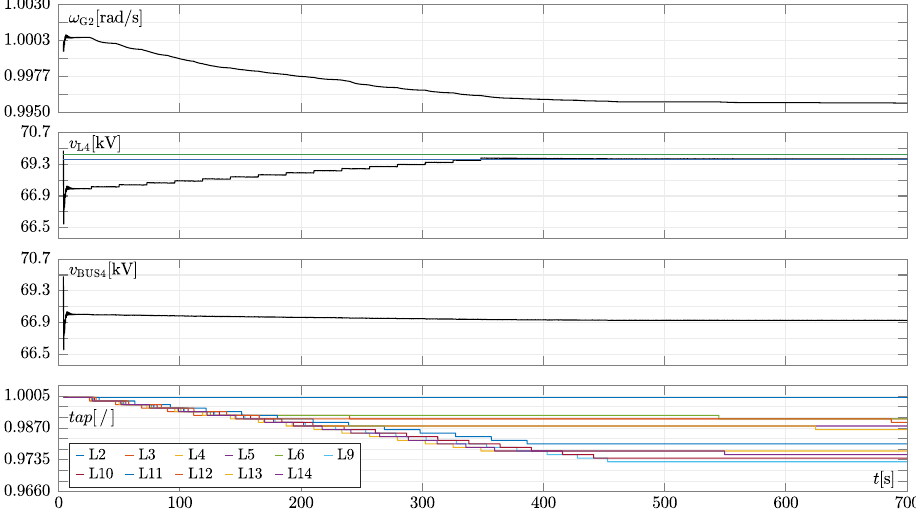
Figure 11. Simulation results of the modified IEEE 14 test system shown in Figure 6 when the line between BUS 2 and BUS 5 is tripped at 4s. In this case, an accurate MMC model is used for both MMC 1 and MMC 2. Constant impedance loads behind OLTC s and non-dynamic line and transformer models are used. The traces in each panel have the same meaning as those in Figure